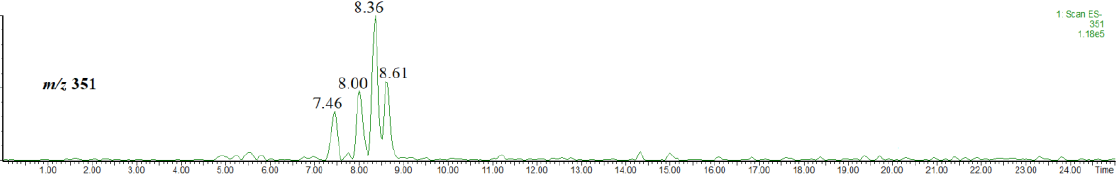
Figure 7. Single ion chromatogram of the ion at m/z 351, thus the [M-H] − ion of methyl couma- roylquinates.